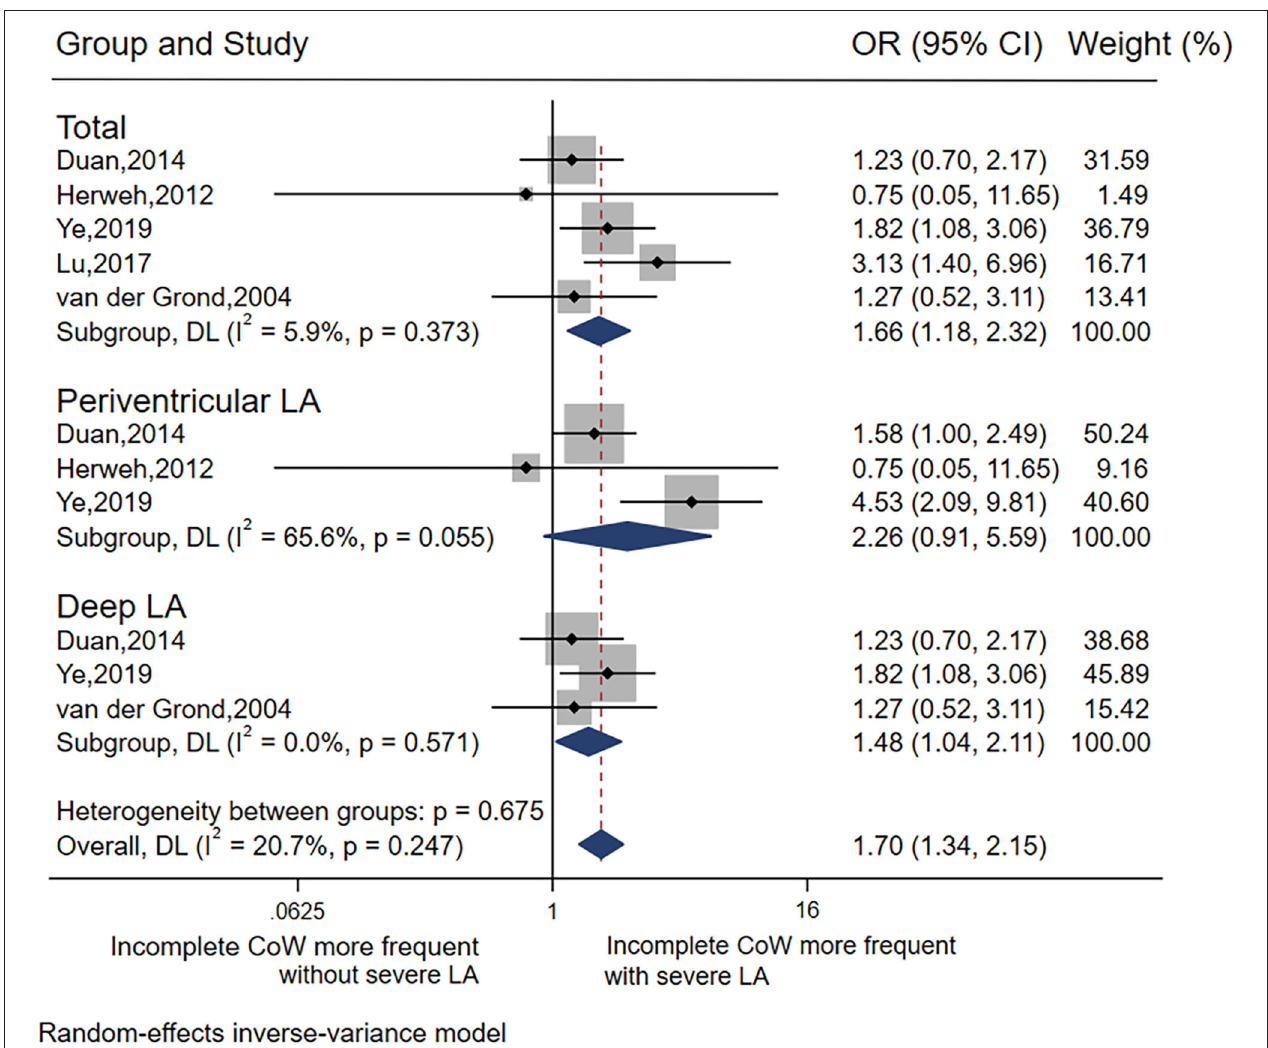
FIGURE 2 | Forest plot for the association between LA distribution and